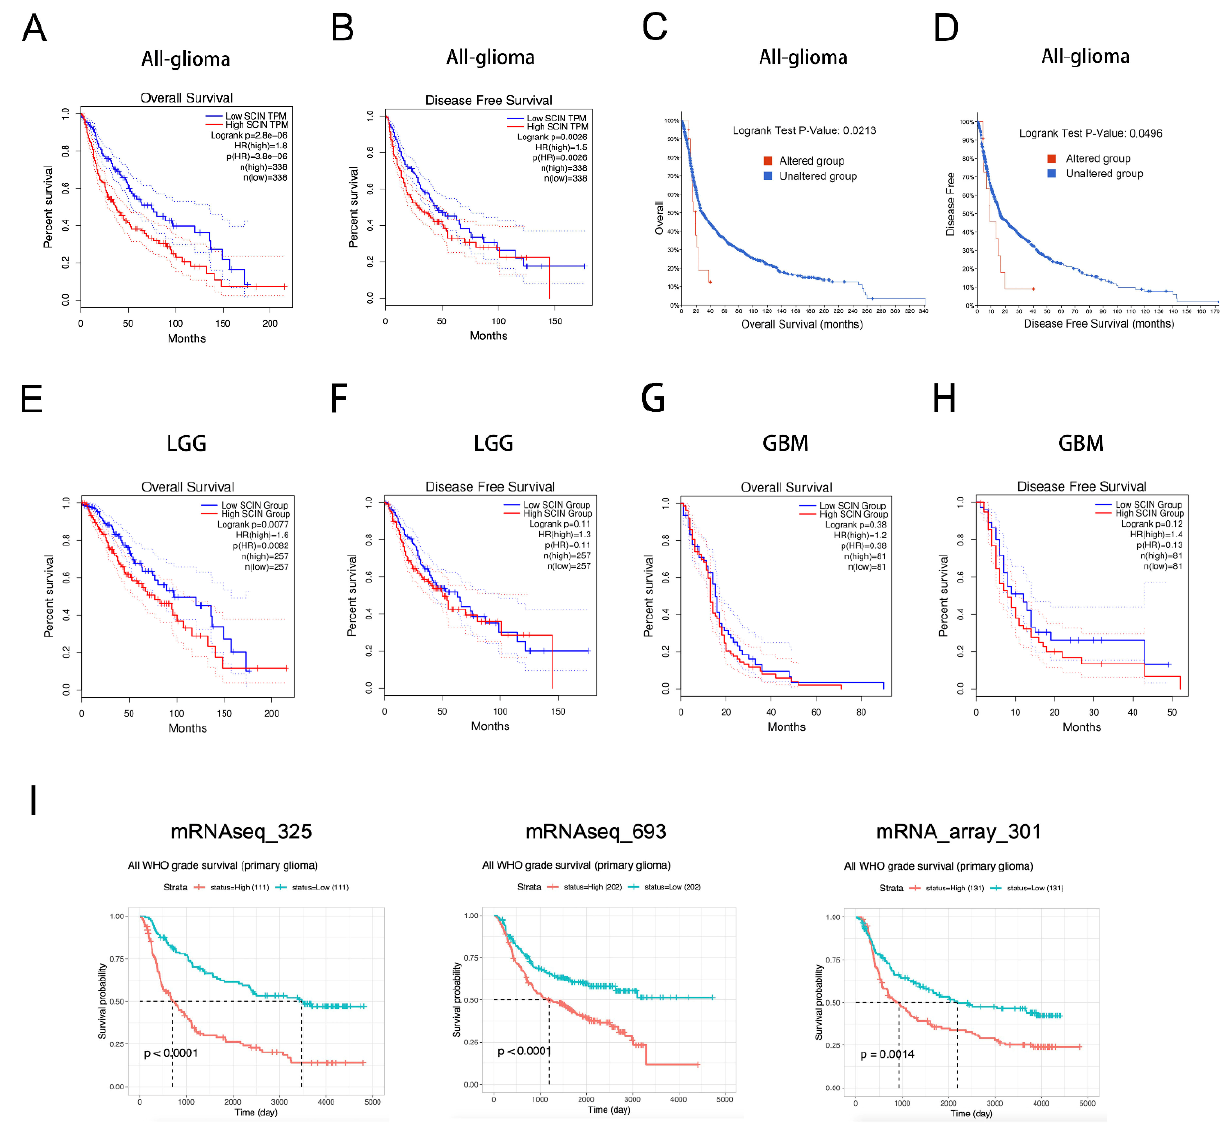
Figure 2. Scinderin (SCIN) is a prognostic biomarker in glioma. ( A ) Overall survival (OS) in glioma patients with high or low level of SCIN analyzed in the Gene Expression Profiling Interactive Analysis (GEPIA)dataset ( p < 0.001). ( B ) Disease-free survival (DFS) in glioma patients with high or low level of SCIN analyzed in the GEPIA dataset ( p = 0.0026). ( C ) OS in glioma patients was divided into two groups according to SCIN alternation ( p = 0.0213). ( D ) DFS in glioma patients was divided into two groups according to SCIN alternation ( p = 0.0496). ( E , F ) OS ( p = 0.0077) and DFS ( p = 0.11) analysis based on SCIN expression level in LGG from the GEPIA dataset. ( G , H ) OS ( p = 0.38) and DFS ( p = 0.12) in GBM from the GEPIA dataset. ( I ) Chinese Glioma Genome Atlas (CGGA) analysis of the prognostic significance of SCIN expression in glioma patients in three datasets ( p <